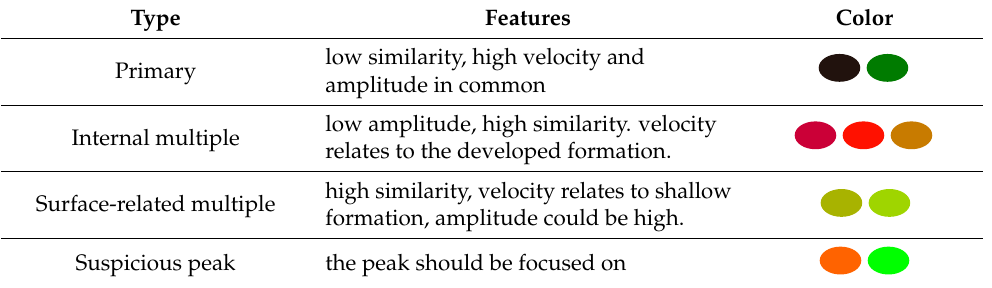
Table 3. Analysis for the color spectra. Type Primary relates to the developed formation.